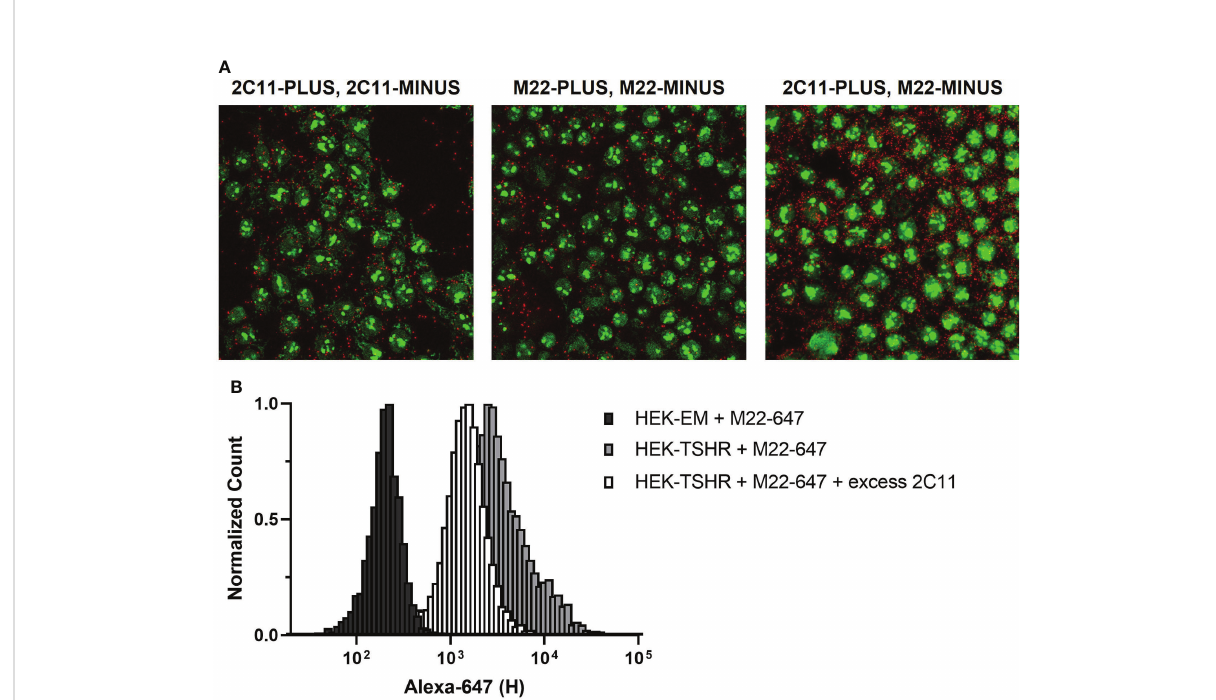
FIGURE 4 TSHR Duolink in HEK-TSHR. When PLUS and MINUS conjugates of the same monoclonal antibody are used in PLA, signals will only be produced when PLUS and MINUS conjugates bind to different protomers in a homodimer. We show this in fi xed HEK-TSHR cells (A) . Anti-TSHR antibodies 2C11 and M22 were directly conjugated to PLUS and MINUS probes and used to detect TSHR. TSHR homodimers were detected with 2C11-PLUS/MINUS (left) and M22-PLUS/MINUS (middle). In contrast, the higher number of PLA signals detected using 2C11-PLUS and M22- MINUS are from both TSHR homodimers and individual TSHR (right). Since 2C11 and M22 bind to different epitopes on TSHR, it is possible for the two antibodies to bind simultaneously to the same receptor. This was supported experimentally using fl ow cytometry (B) . M22 was conjugated to Alexa Fluor 647 (M22-647) and used to detect TSHR in HEK-TSHR cells. M22-647 bound non-speci fi cally to HEK parental cells (black bars), which do not express TSHR. In HEK-TSHR cells, binding of M22-647 right-shifted the fl ow cytometry peak (gray bars). An excess of 2C11 did not completely outcompete M22-647 binding (white bars). This is consistent with the idea that M22 and 2C11 may bind to the same TSHR